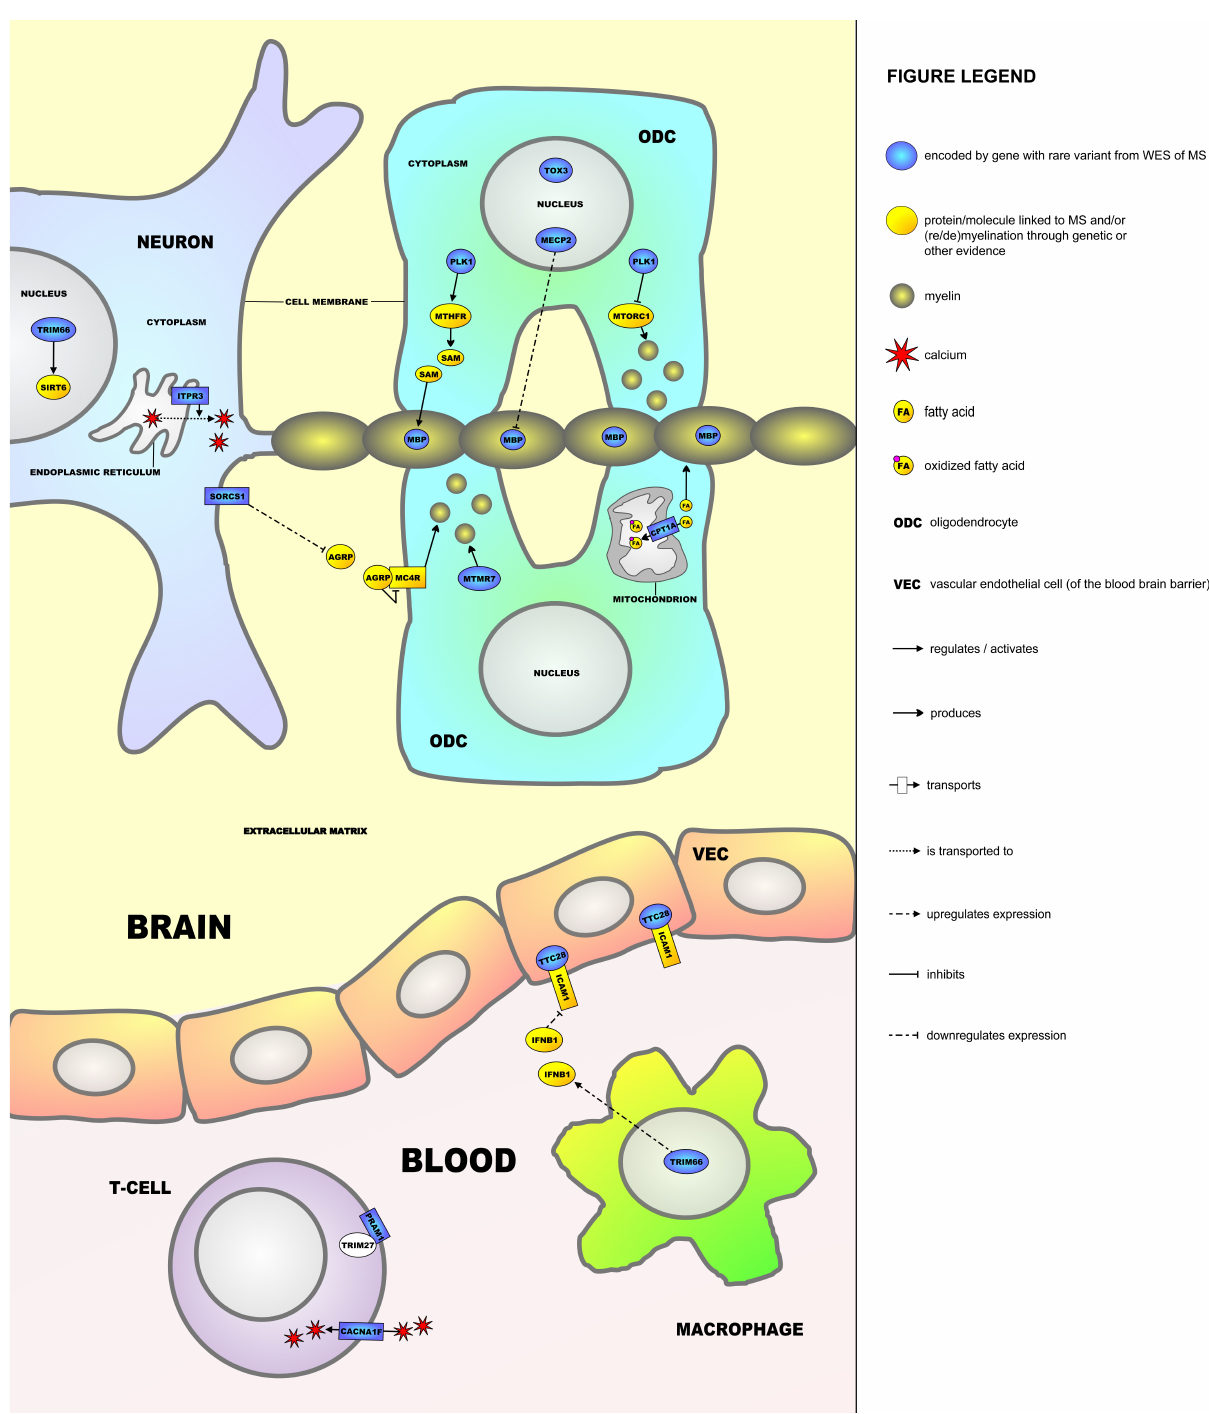
Figure 1. A molecular framework containing 12 interacting proteins encoded by genes harboring rare variants that were identified through WES in nine multi-incident MS families. MBP, PLK1, MECP2, MTMR7, TOX3, CPT1A, SORCS1, TRIM66, ITPR3, TTC28, CACNA1F, and PRAM1 are all linked to (de-/re)myelination and/or the auto-immune response characteristic of